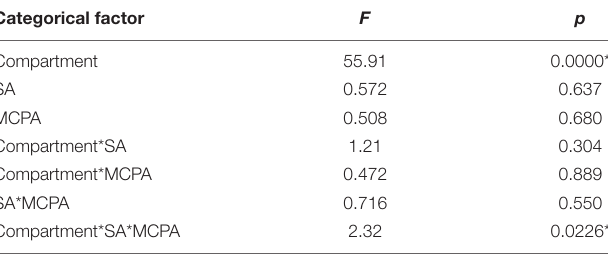
TABLE 5 | Main effects of categorical factors (compartment vs. SA vs. MCPA treatment) on diversity indices, estimated using Multivariate Tests of Significance